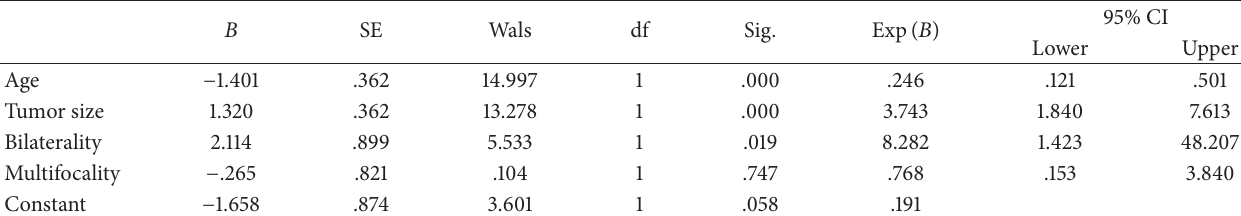
Table 2: Multivariate analysis of the correlations between CLNM and clinicopathologic characteristics of cN 0 CPTC.